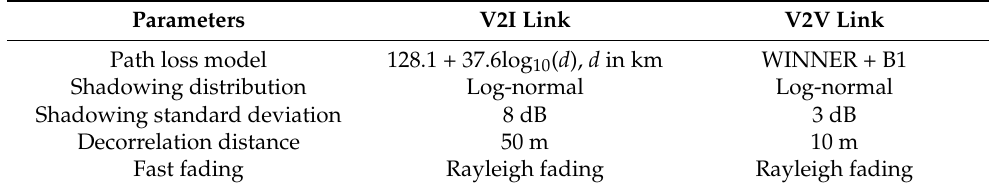
Table 2. Channel